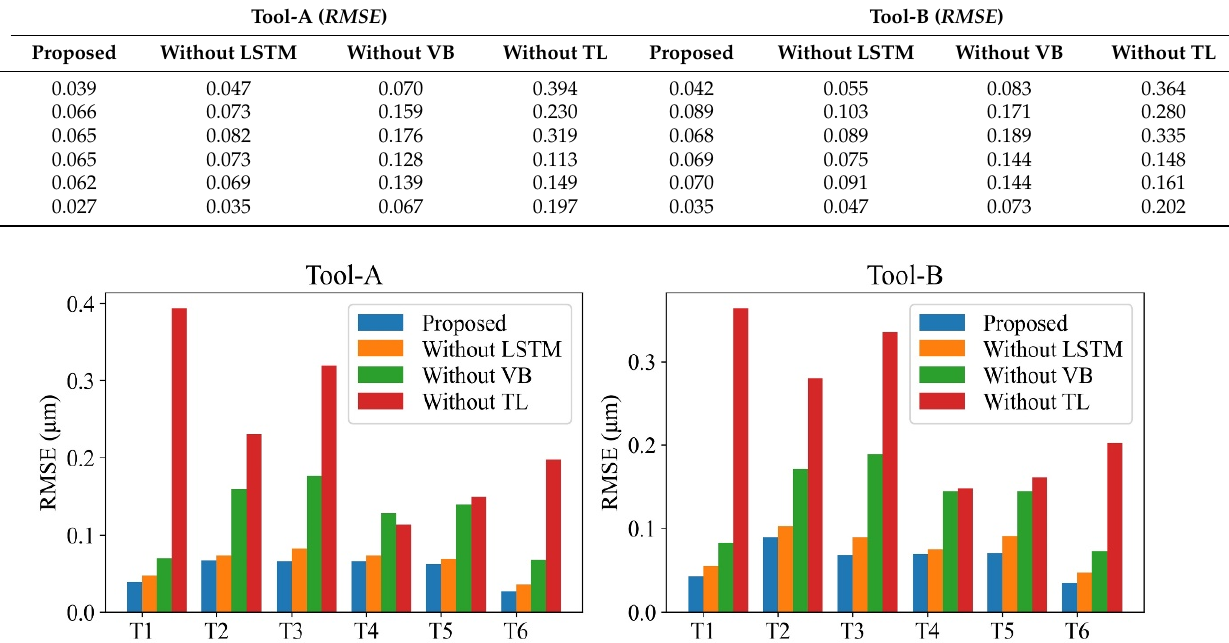
Figure 14. Prediction results considering each transfer task under different models. Table 8. MAPE of all six transfer tasks and MAPE of [32,57,58].